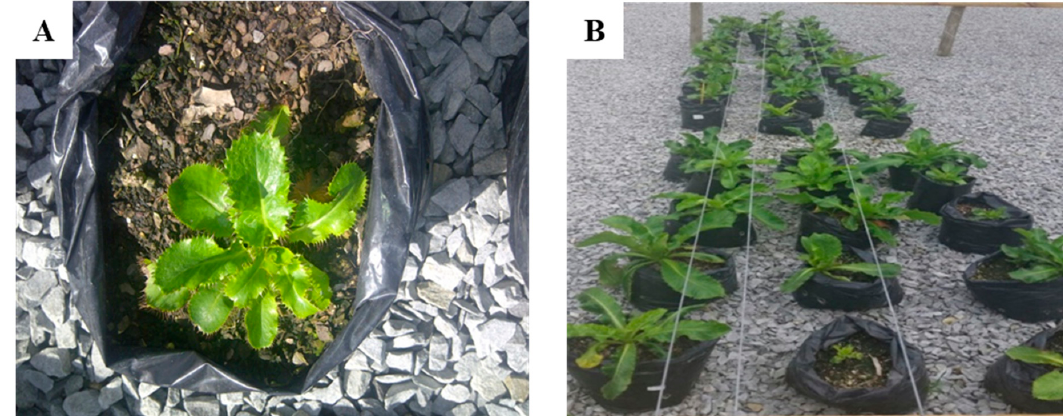
Figure 2. Cultivation of A. amatymbica ( A ) Shoots emerging from rhizome ( B ) Plants raised through rhizome segments growing in the greenhouse.